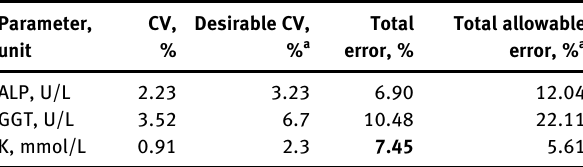
Bold number indicates total error exceeding the total allowable error. ALP, alkaline phosphatase; GGT, gamma-glutamyl transferase;